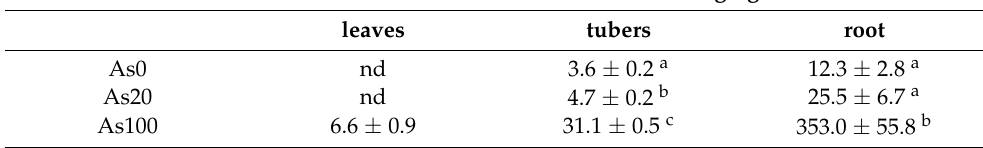
Table 1. Content of As in dry biomass of cherry radish. Values represent the mean ± SD. Data with the same letter are not significantly different. Different letters indicate significant differences ( p < 0.05) among treatments according to ANOVA with Tukey’s post-hoc test. Abbreviations: As0—0 mg As/kg soil (control); As20—20 mg As/kg soil; As100—100 mg As/kg soil; nd—value is under the detection limit of ICP-OES (3 mg/L); DM—dry matter. As Content in Plant Parts (mg/kg DM) leaves